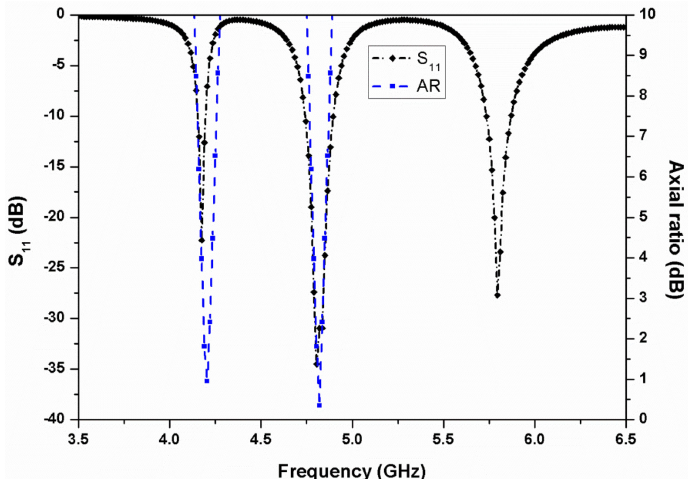
Figure 3. Simulated S 11 and axial ratio of the stacked antenna element.